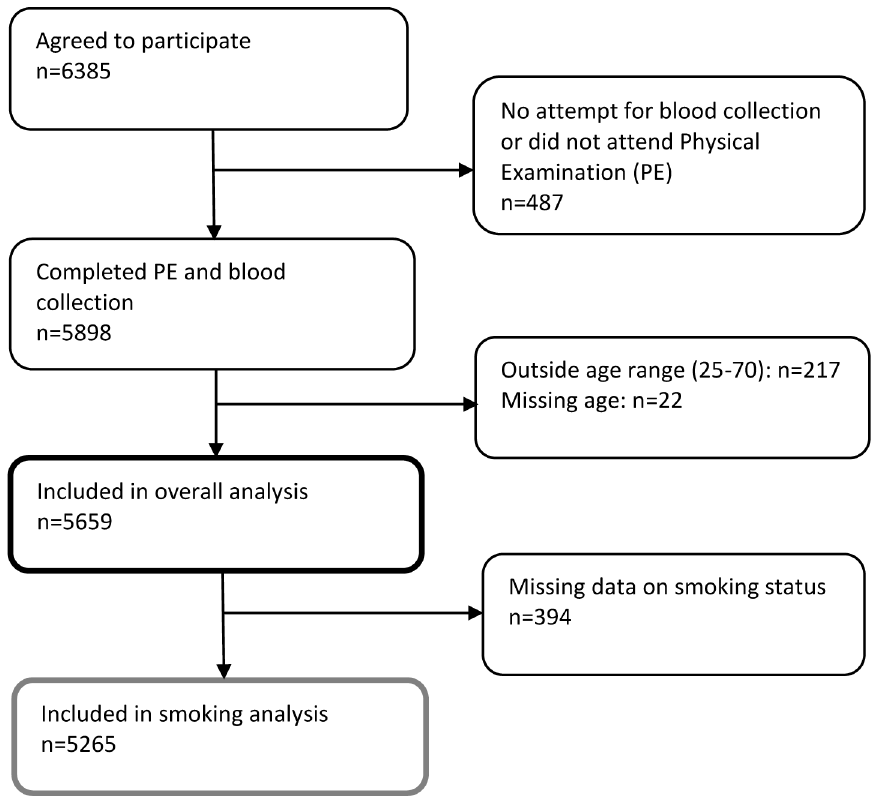
Fig 1. Flow chart showing inclusion of RODAM participants in smoking